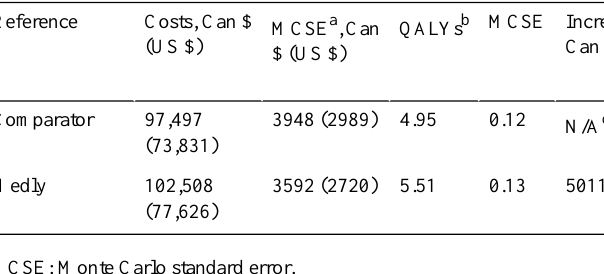
Table 5. Deterministic results of the reference case